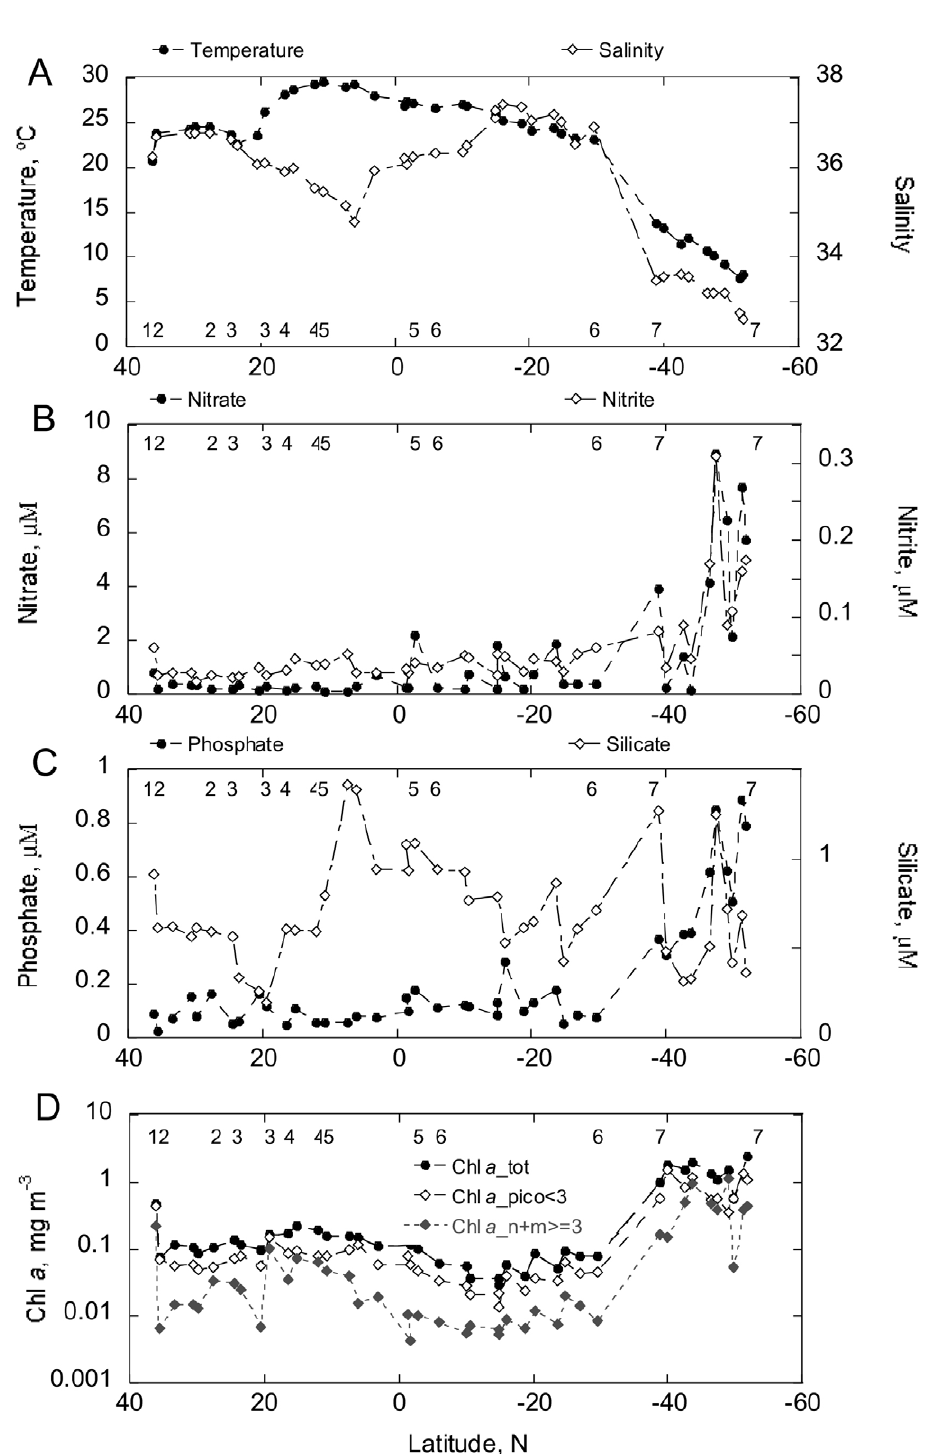
Fig. 2. – Variations of temperature (°C) and salinity (A), nitrate (µM) and nitrite (µM) (B), phosphate (µM) and silicate (µM) (C) and Chl a (mg m –3 ) for the total community (Chl a _tot) and for the <3 µ (Chl a _pico<3) and ≥ 3 µm (Chl a _n+m ≥ 3) size classes (D), in the TransPEGASO transect. The numbers above the top or bottom axes indicate the provinces: 1, MEDI; 2, NAST-E; 3, CNRY; 4, NATR; 5, WTRA; 6, SATL; 7,